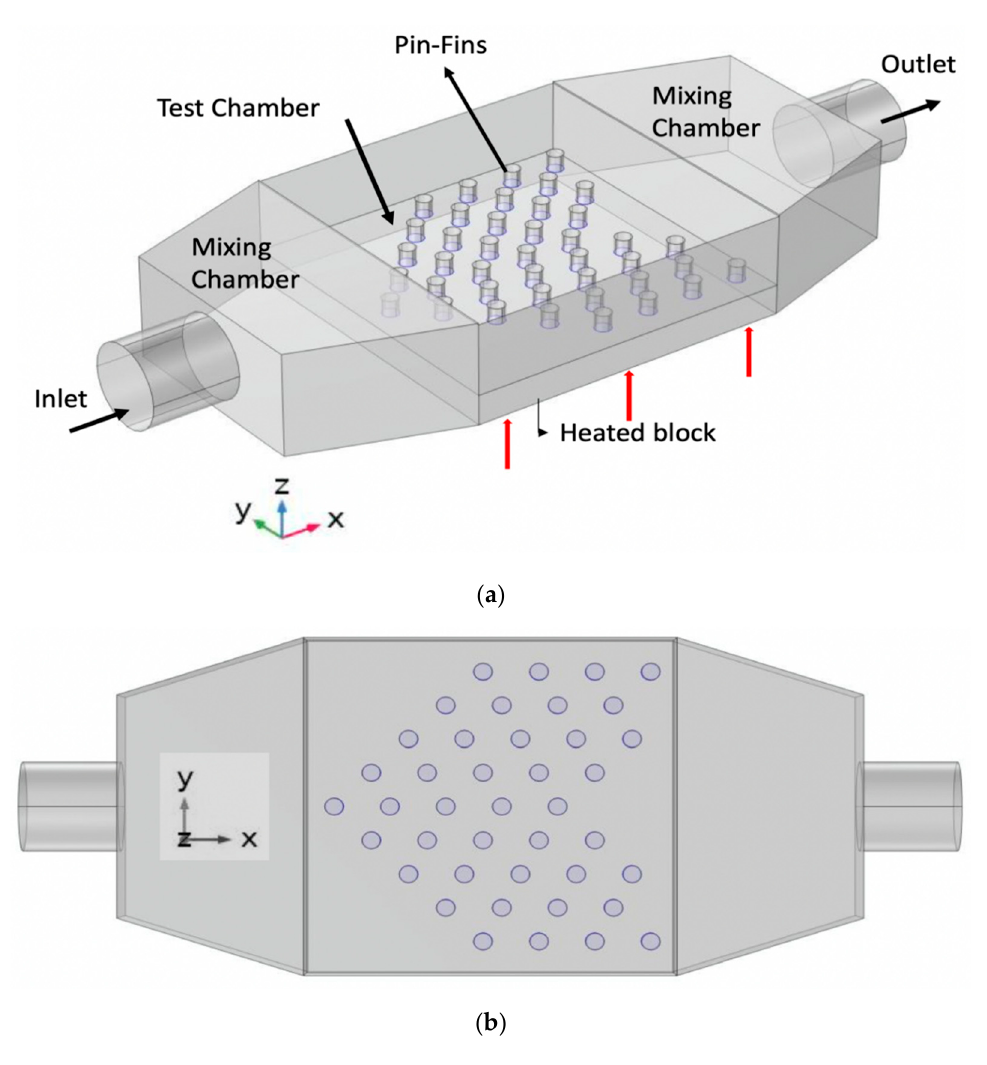
Figure 1. Model description: ( a ) 3D View; ( b ) Top View.